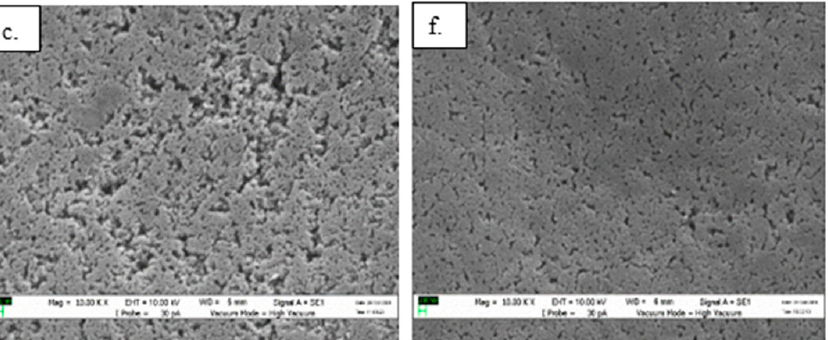
Figure 3. Surface morphology of Seplite LX120 before and after immobilization with EstD9. Images ( a – c ) show the empty Seplite LX120, while ( d – f ) show bound support of the enzyme at magnifications of 20 × , 5000 × and 10,000 × , respectively.